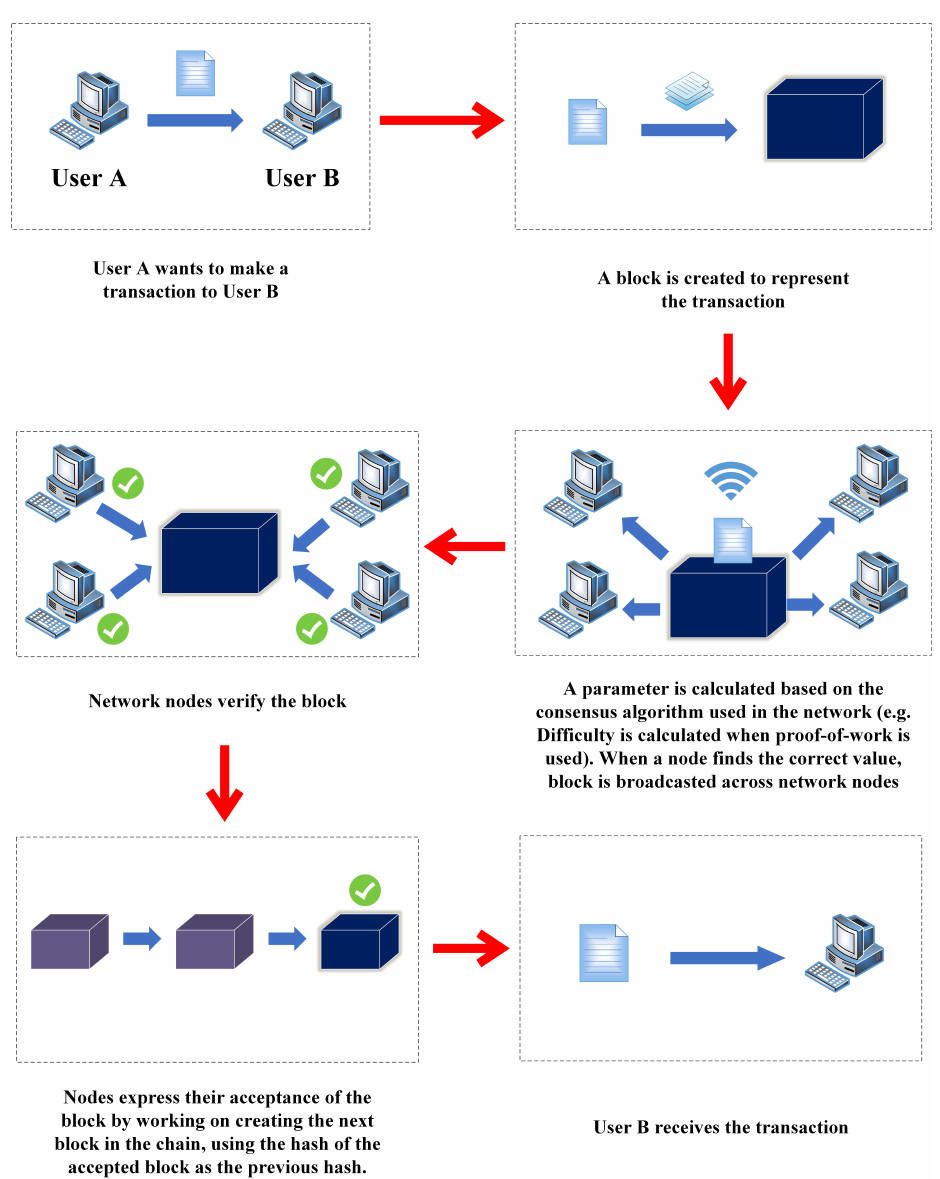
Figure 1. Blockchain